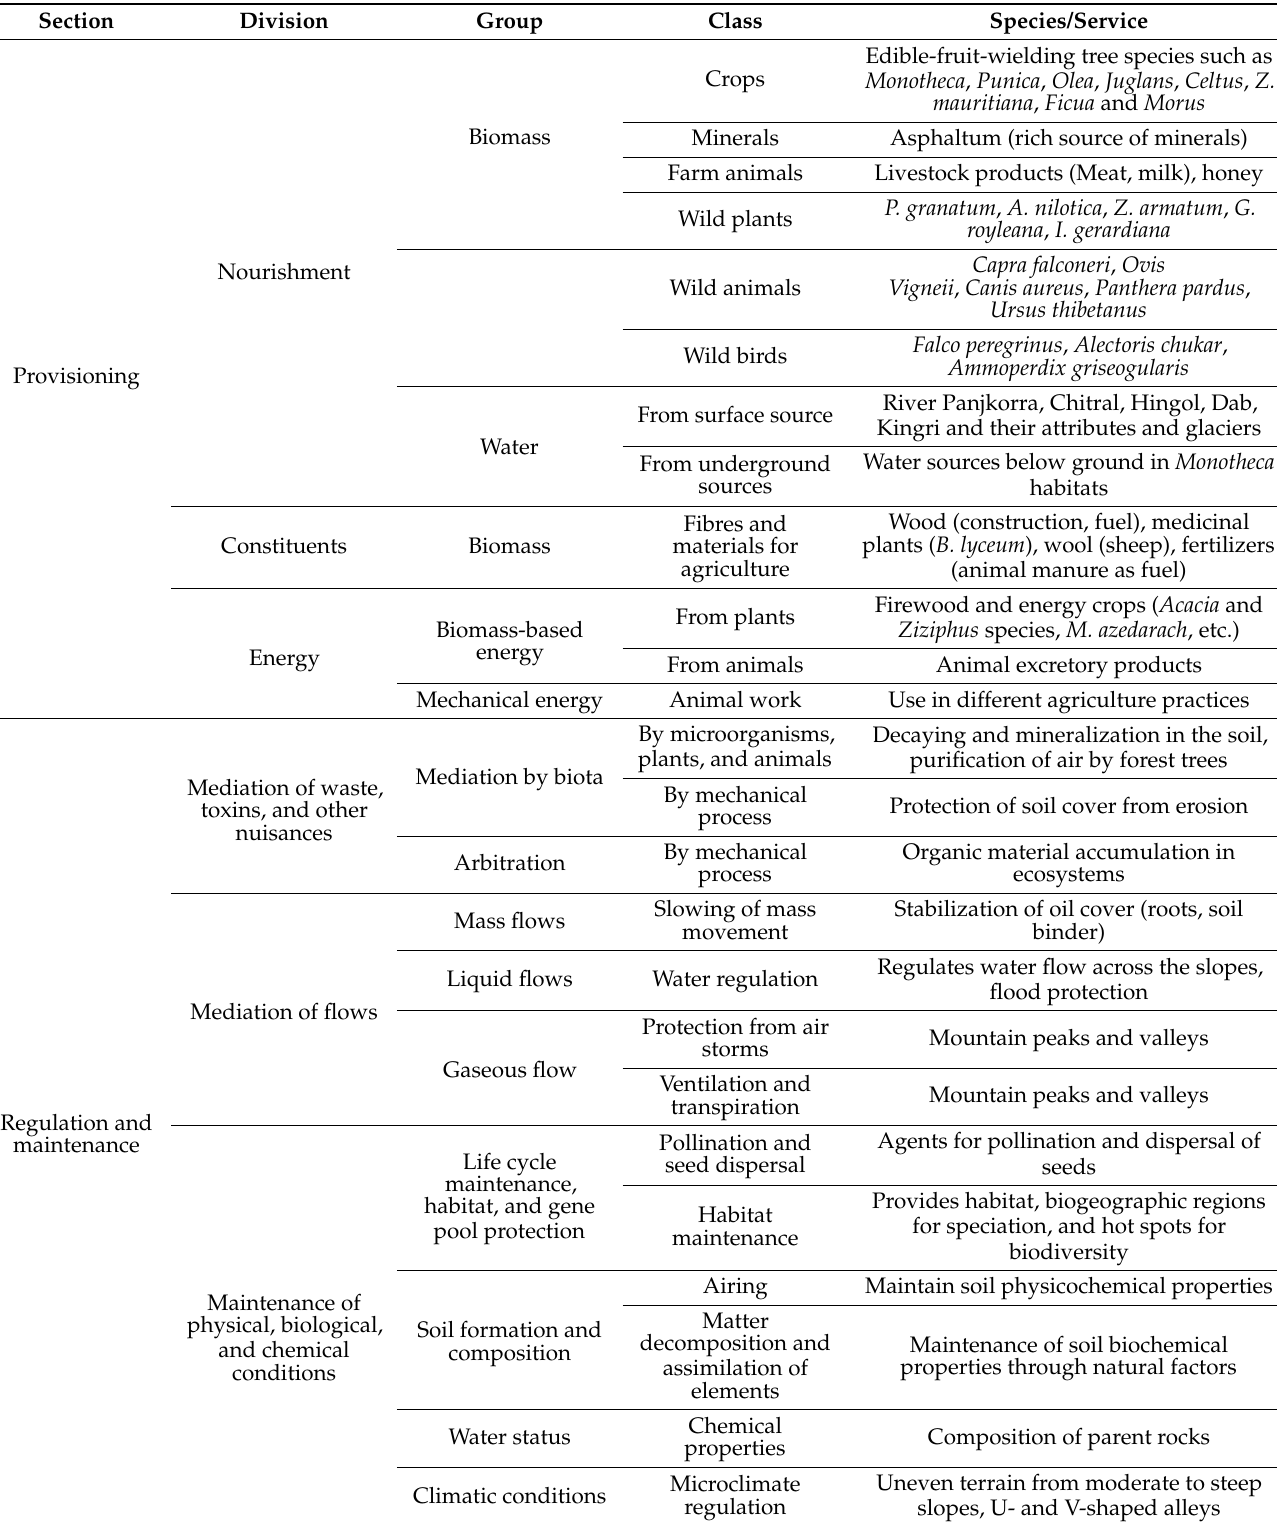
Table 5. * Ecosystem services provided by Monotheca forests in